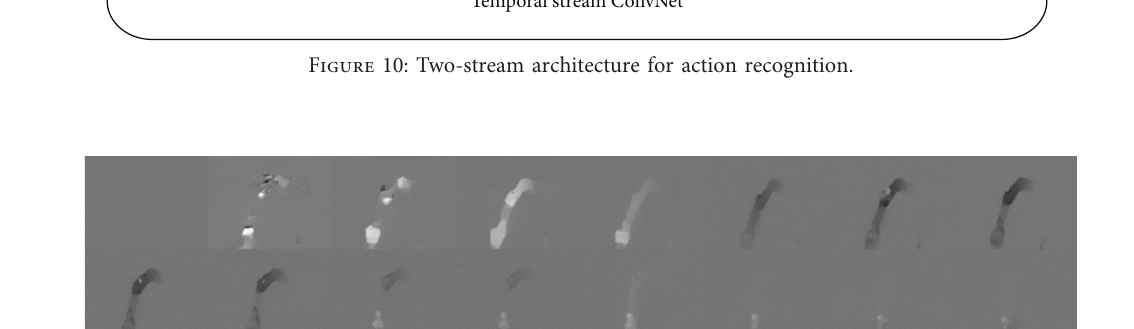
Figure 10: Two-stream architecture for action recognition.